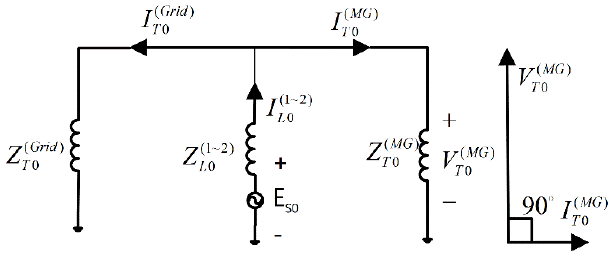
Figure 2. A simplified zero-sequence network for grid single line-to-ground (SLG) fault.